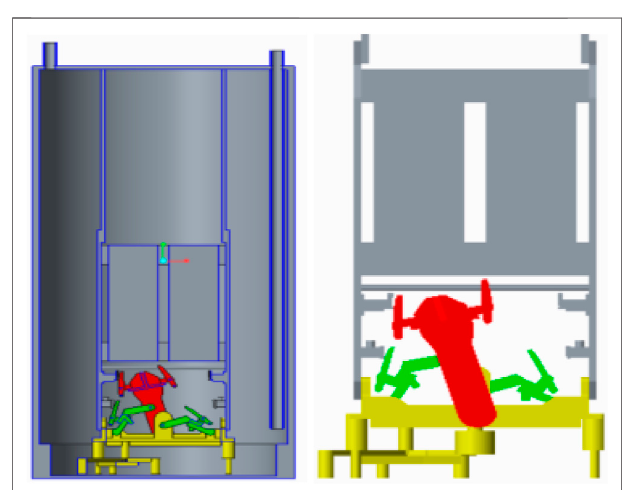
FIGURE 6 | Integral model of the OLTC.